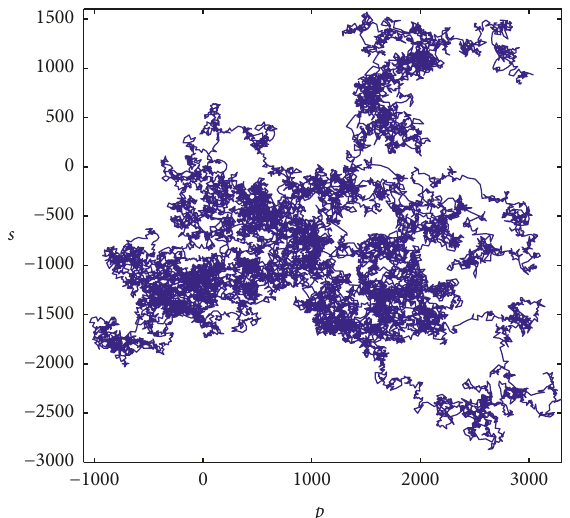
Figure 2: 0–1 test of improper fractional-order memristive